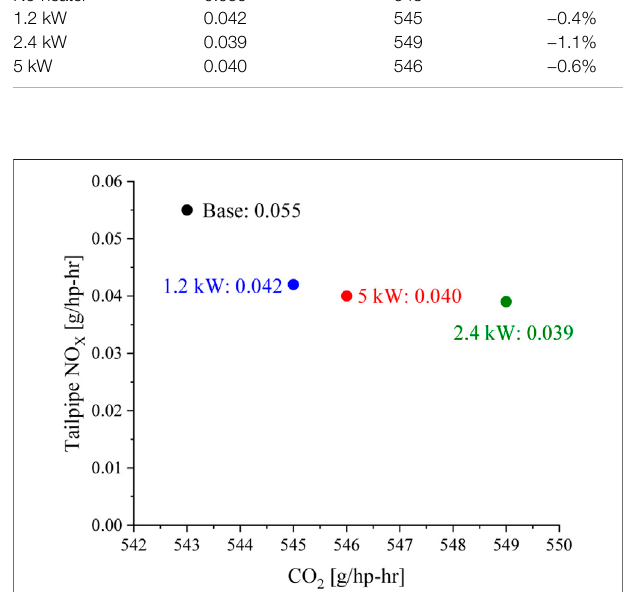
FIGURE 3 | Cold FTP results.